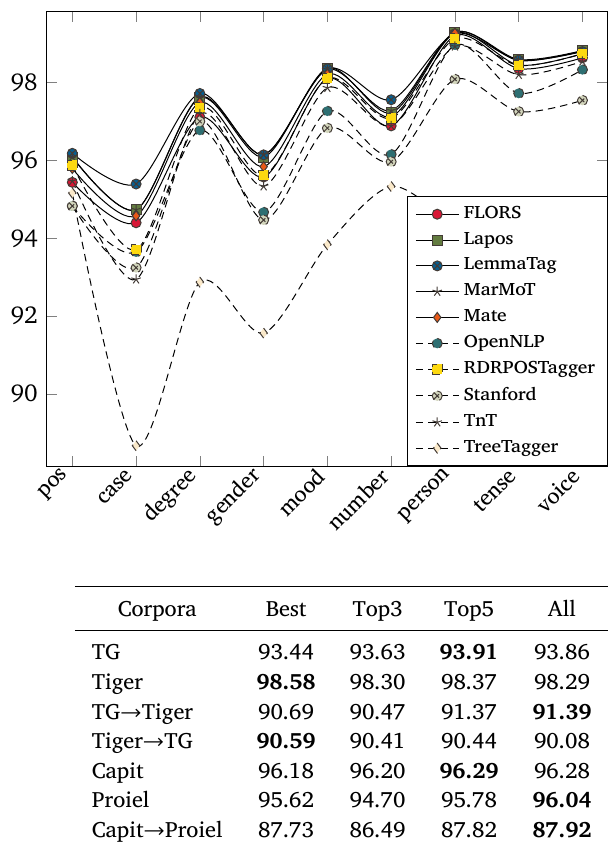
Majority vote tagging of POS (STTS/CHSTS) (accuracy in